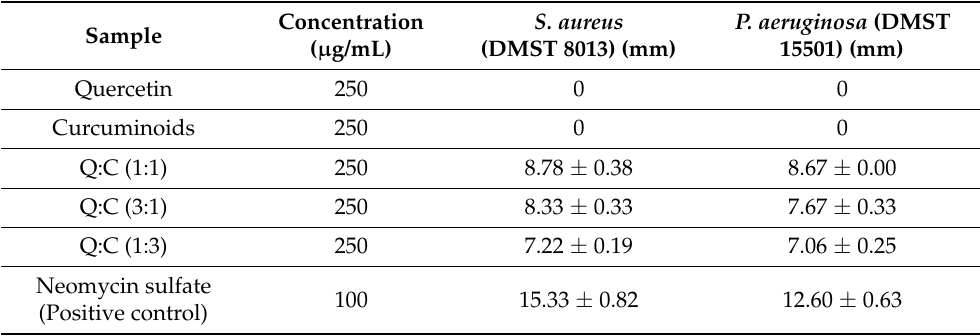
Table 1. Zone of inhibition (mm) of quercetin, curcuminoids and quercetin/curcuminoid mixtures at 1:1, 3:1 and 1:3 ratios against S. aureus (DMST 8013) and P. aeruginosa (DMST